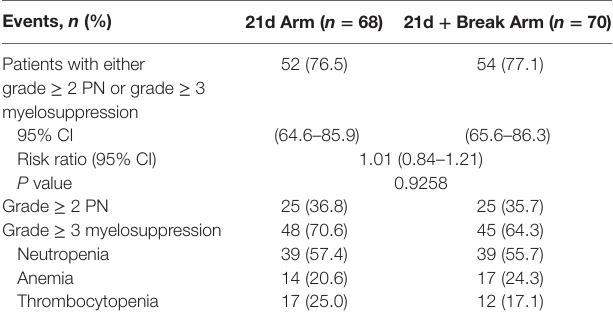
TaBle 2 | Primary endpoint.